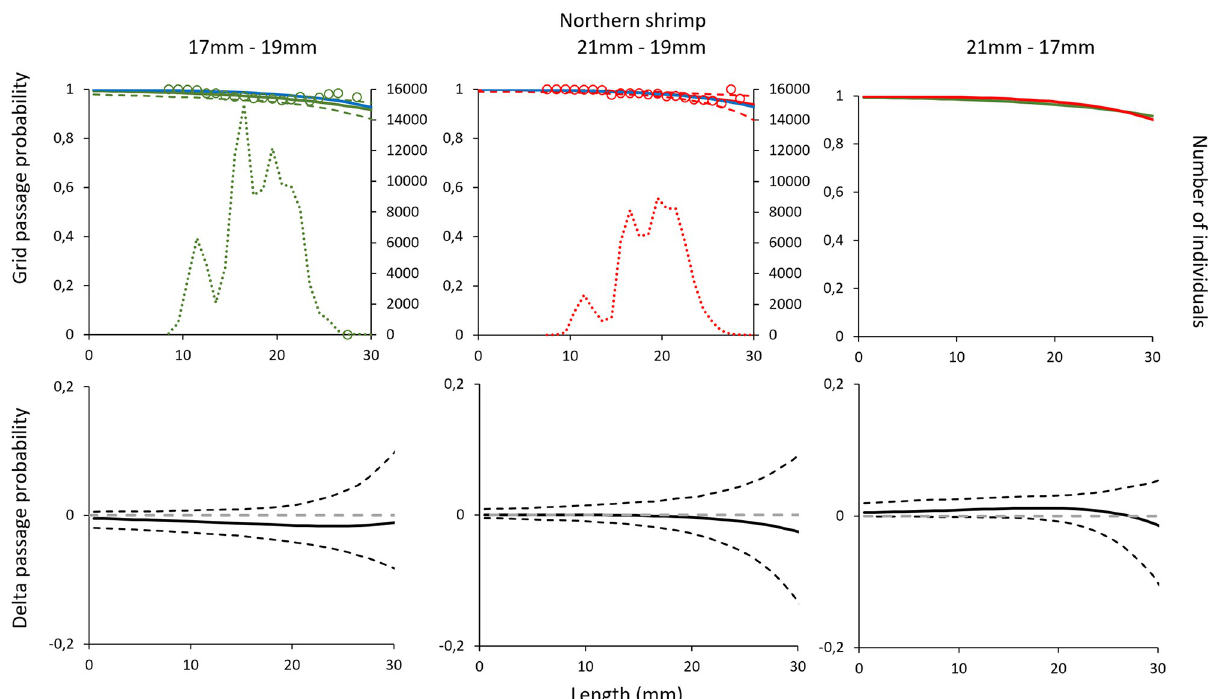
Fig 2. Grid passage probability for Northern shrimp (a-c). Circles illustrate experimental rates, solid curves represent the fitted model, and stippled curves are the 95% CI’s. Green lines and circles represent the data for grid with 17 mm bar spacing, red– 21 mm grid spacing, and blue line–grid with 19 mm grid spacing. Dotted green and red lines represent total population size structure retained by the gear. Plots d-f show the difference in the length-dependent grid passage probability (delta) between the different grids with 95% CI’s (stippled lines).